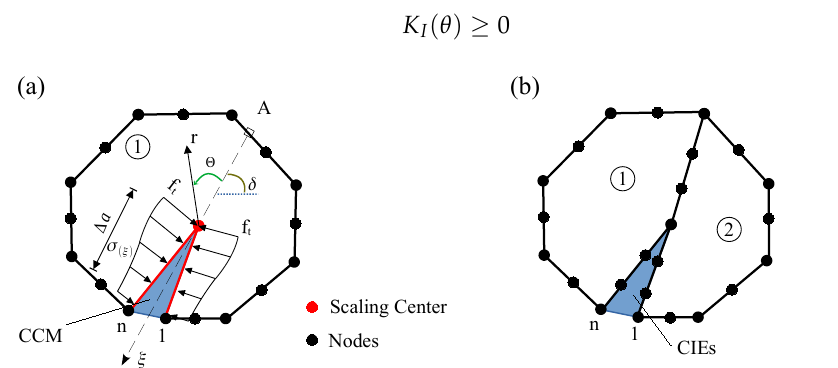
Figure 2. Calculation of k I using shadow domain method: ( a ) cohesive crack model (CCM) in SBFEM; ( b ) subdomain